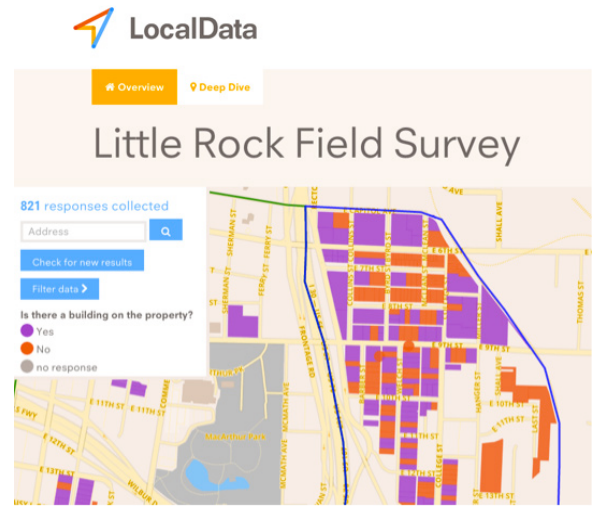
Figure 5. View of the back-end, quality-control analytics pro- cess during the Little Rock Relocal project (Source: PlaceEconomics and LocalData, 2015)